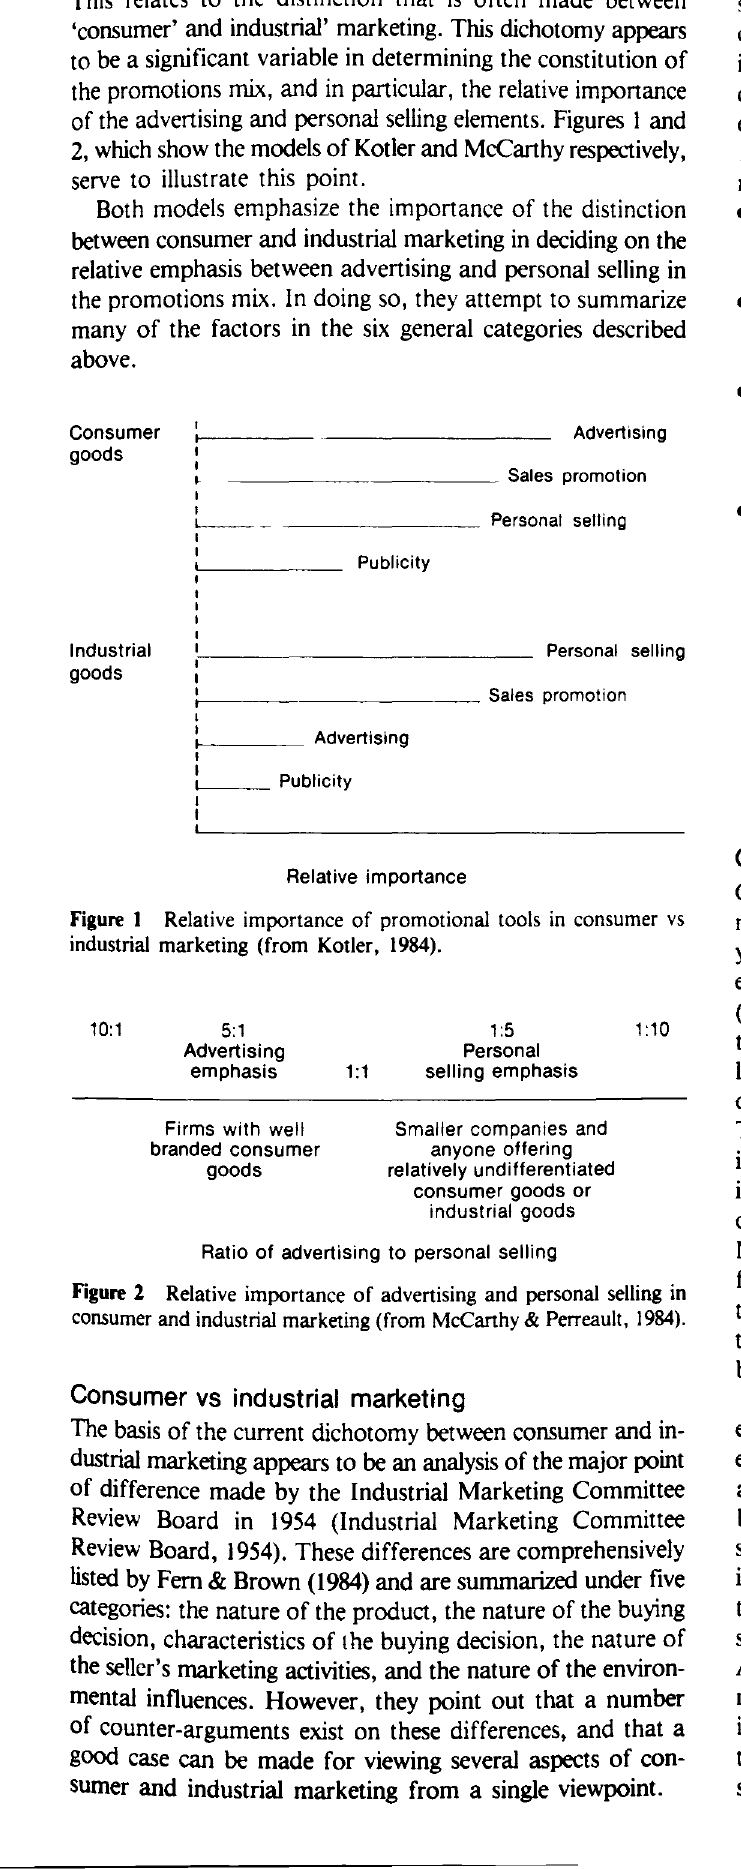
Figure 2 Relative importance of advertising and personal selling in consumer and industrial marketing (from McCarthy & Perreault,